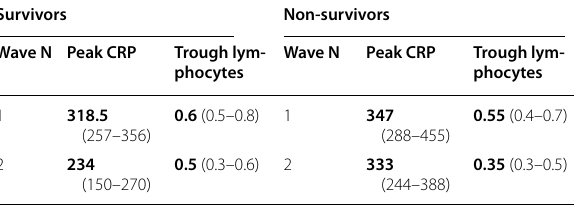
Table 1: medians and quartiles (1–3) of peak CRPs and trough lympho- cytes for survivors versus non-survivors of the first and second waves. Regarding the trough lymphocyte counts, there was no statistical dif- ference between any of the groups correspondingly. Regarding the peak CRP levels: there was a trend towards the second wave survivors having lower peak CRPs as compared with the second wave non-survi- vors (p—0.021) or the first wave survivors (p—0.017), but these have not reached the target p-value. Conclusion. The trend of the second wave SARS-CoV-2 survivors towards lower peak CRP could have reached the statistical significance if 10 patients’ data (10% mortality) were not rendered unavailable due to non-clinical transfers. This is plausible as there was a ubiquitous use of steroids during the second wave secondary to recommenda- tions of the Recovery trial. ‘CRP responsiveness’ to steroids was linked to improved survival previously. Finally, in our small cohort, peak CRP does not clearly differentiate between survivors and non-survivors. Therefore, other clinical parameters need to be considered for this purpose in larger